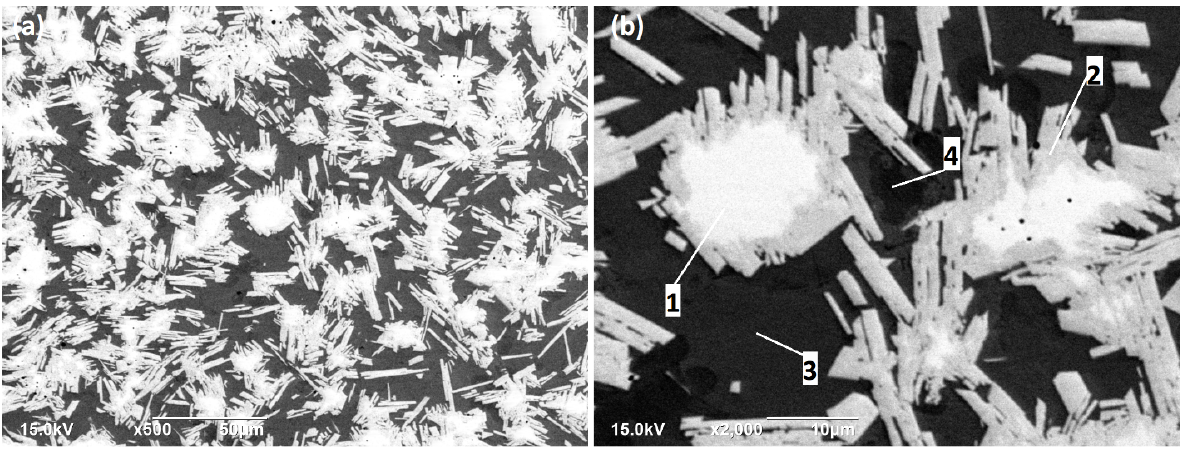
Figure 5: SEM/BSE images of the as-cast alloy sample D with the magnifications of a) × 500 and, b) × 2000